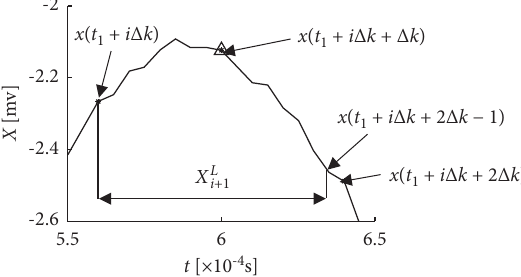
Figure 3: Downsampling result.